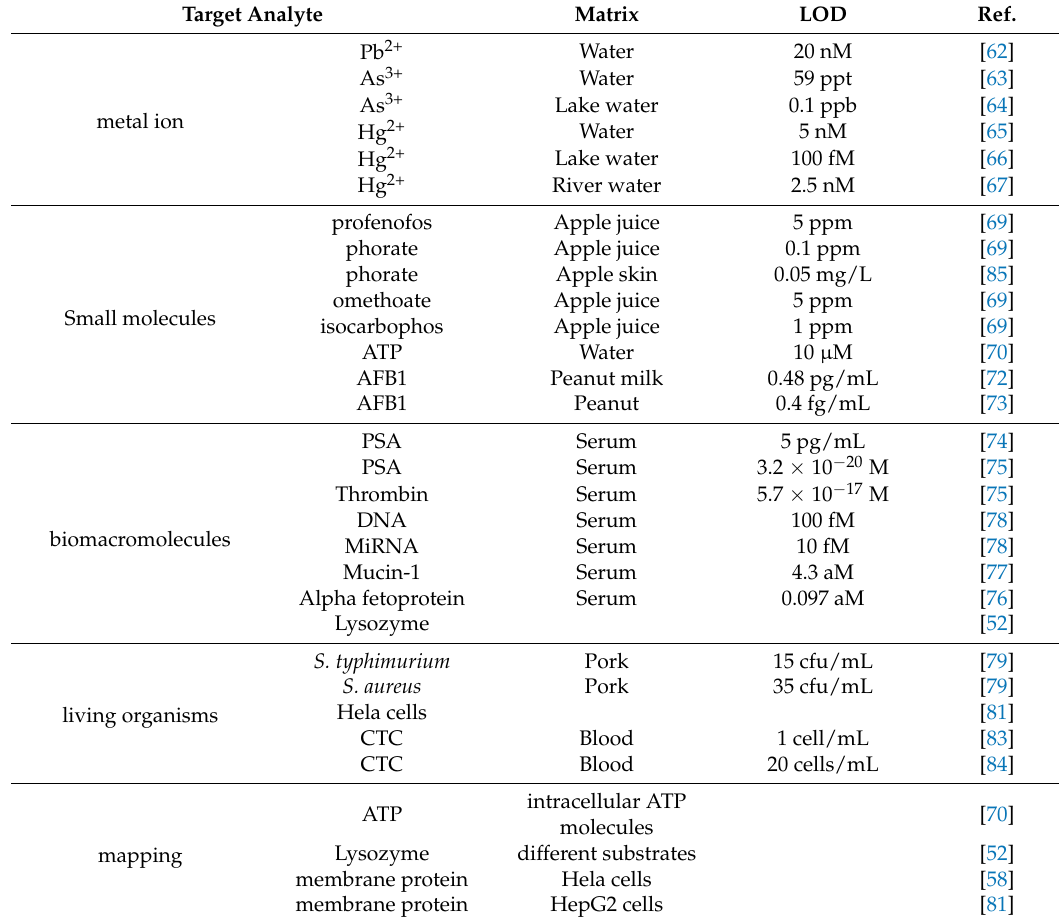
Table 2. Studies of SERS-based